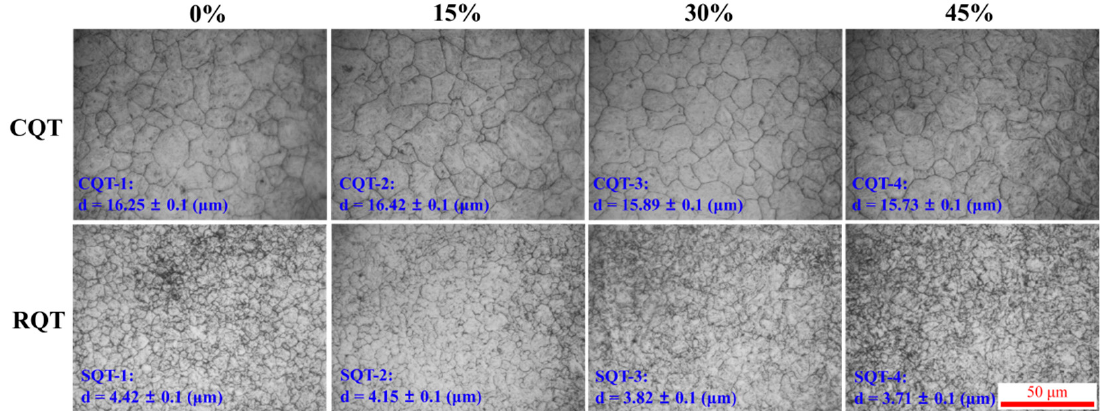
Figure 4. Austenite grain morphology of the experimental steels in different hot rolling reduction after CQT and RQT processes (d is the average grain size).